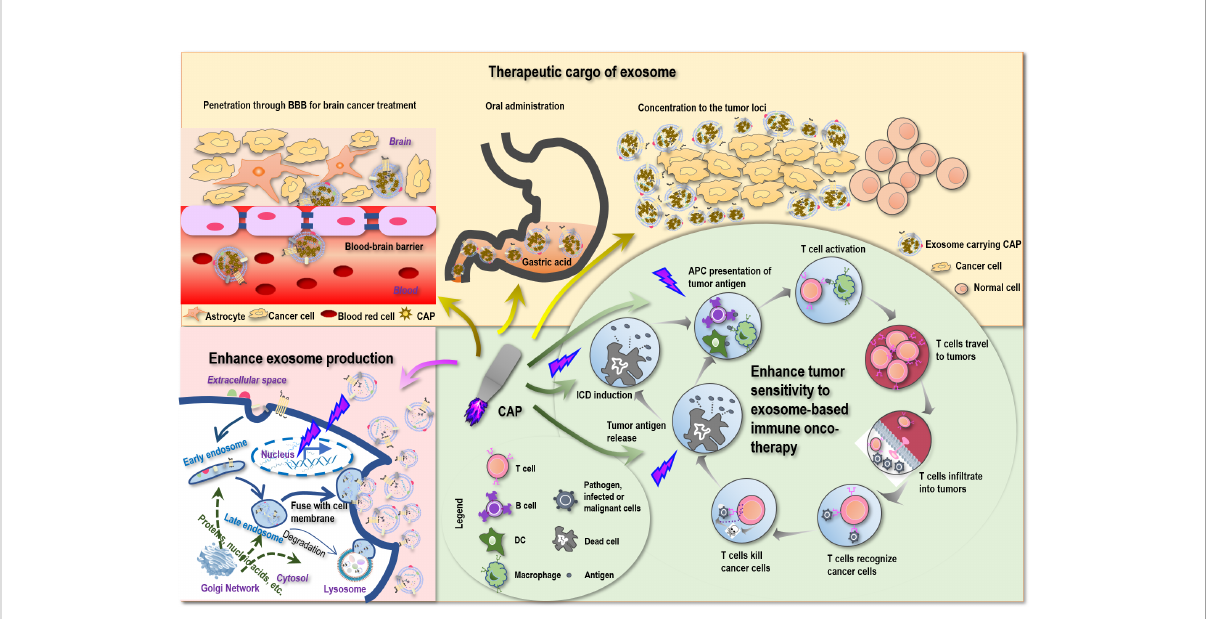
FIGURE 2 Possible scenarios where CAP creates synergies with exosomes toward conceptual and technological onco-therapeutic innovations. First, CAP can promote tumor antigen release, stimulate immunogenic cell death (ICD), enhance tumor antigen presentation by APC cells, and thus can enhance the sensitivity of tumor cells to exosome-based immune onco-therapies. Second, CAP can function as an onco-therapeutic and the cargo of exosomes to treat brain cancers by breaking the blood – brain barrier (BBB), to enable oral intake as a result of increased tolerance to gastric acidity, and to achieve enhanced drug utility by being concentrated to the tumor loci. Third, CAP can stimulate the expression of p53 that ultimately leads to enhanced exosome